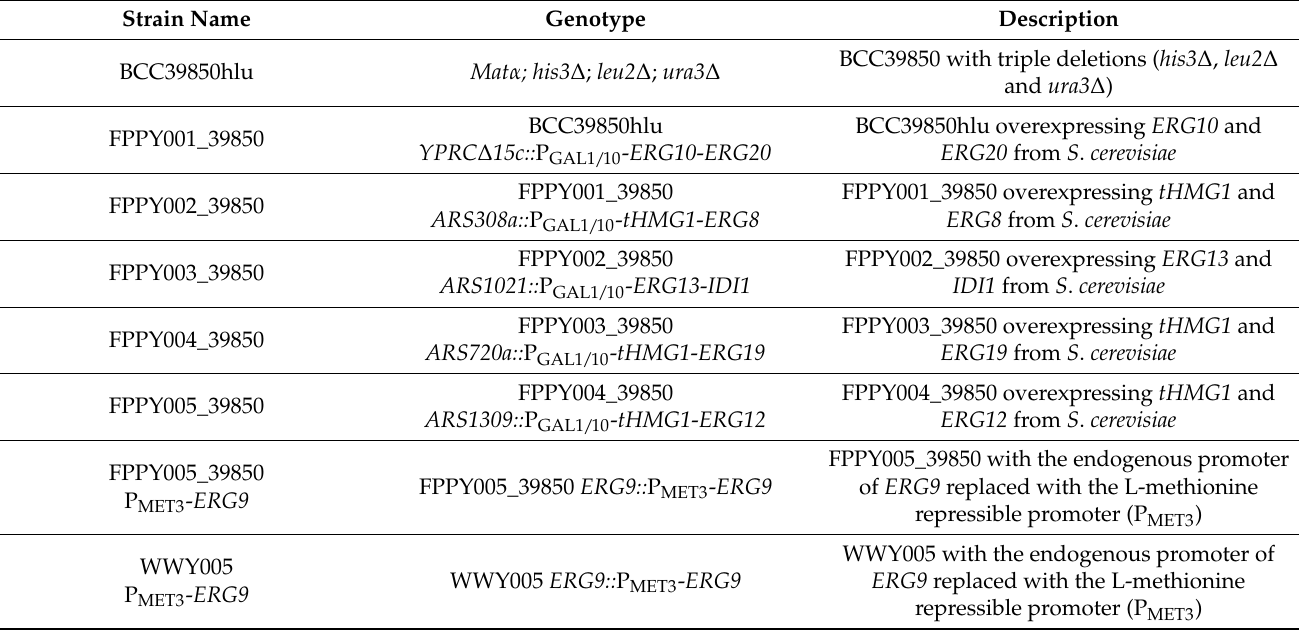
Table 1. Engineered strains generated in this